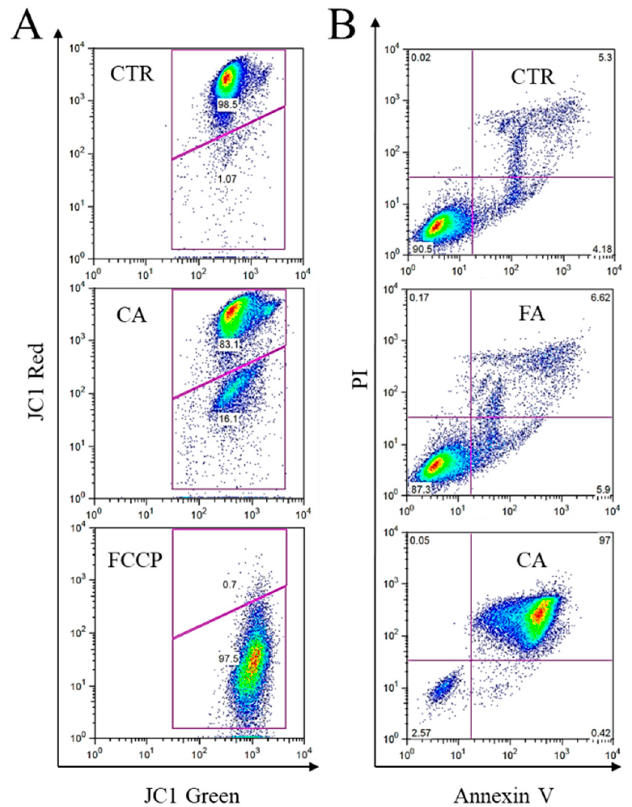
Figure 3. Effects of caffeic acid on triggering apoptosis in K562 cells. ( A ) A representative analysis of the mitochondrial membrane potential was performed by JC-1 staining on cells left untreated (CTR) or treated for two days in the presence of 38 µ M CA. On the day of analysis, the control cells were split into two aliquots and the decoupling agent FCCP was added to one of them for 30 min to cause dissipation of the mitochondrial membrane potential. ( B ) A representative analysis of phosphatidylserine extroversion in cells on the third day of treatment with 76 µ M CA or FA, cytotoxic and not cytotoxic, respectively. Cells were stained with Annexin V/PI. CA, caffeic acid; FA, ferulic acid; CTR, untreated cells.